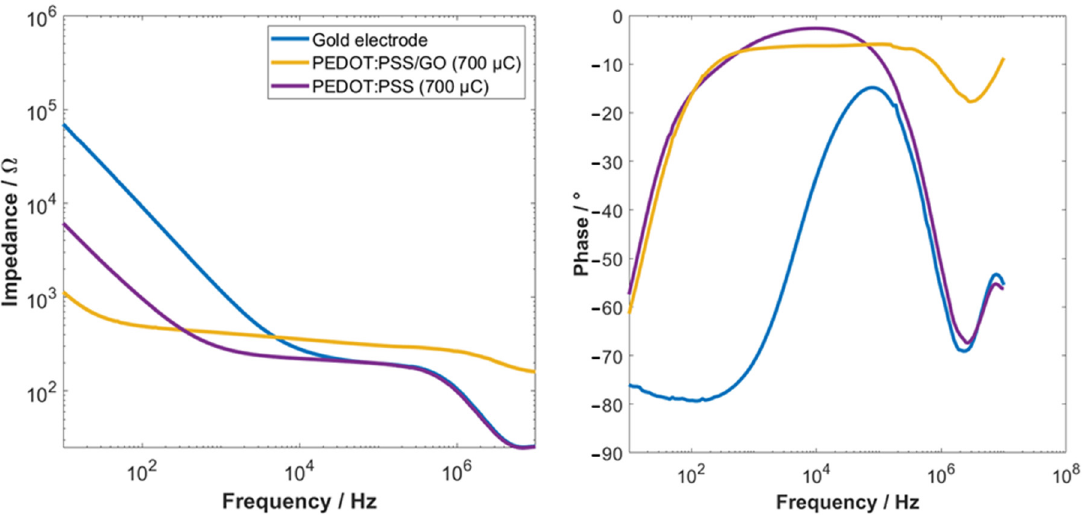
Figure 2. Bode plots of electrochemical impedance spectra ( left ) and phase ( right ) of an Au elec- trode, a PEDOT:PSS-coated Au electrode, and a GO-coated PEDOT:PSS electrode. a PEDOT:PSS-coated Au electrode, and a GO-coated PEDOT:PSS electrode. PEDOT:PSS-coated electrodes (termination charge of 10 µ C and 700 µ C) were PEDOT:PSS-coated electrodes (termination charge of 10 µC and 700 µC) were coated